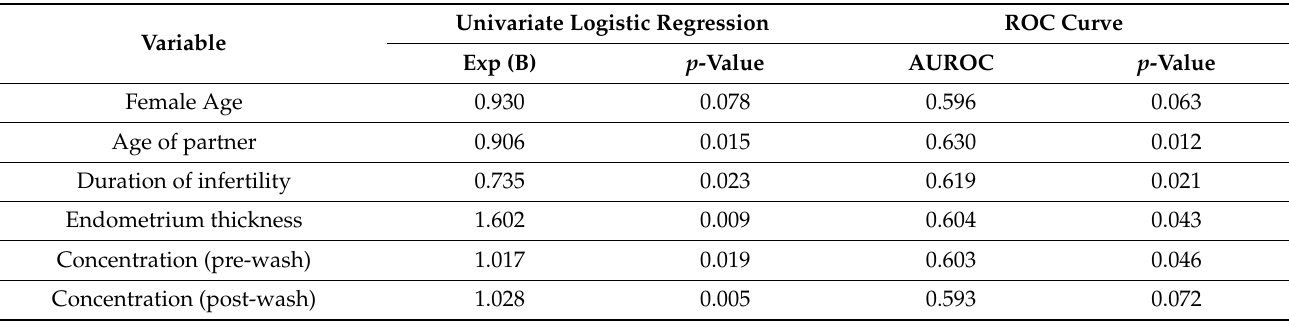
Table 2. Univariate logistic regression and ROC